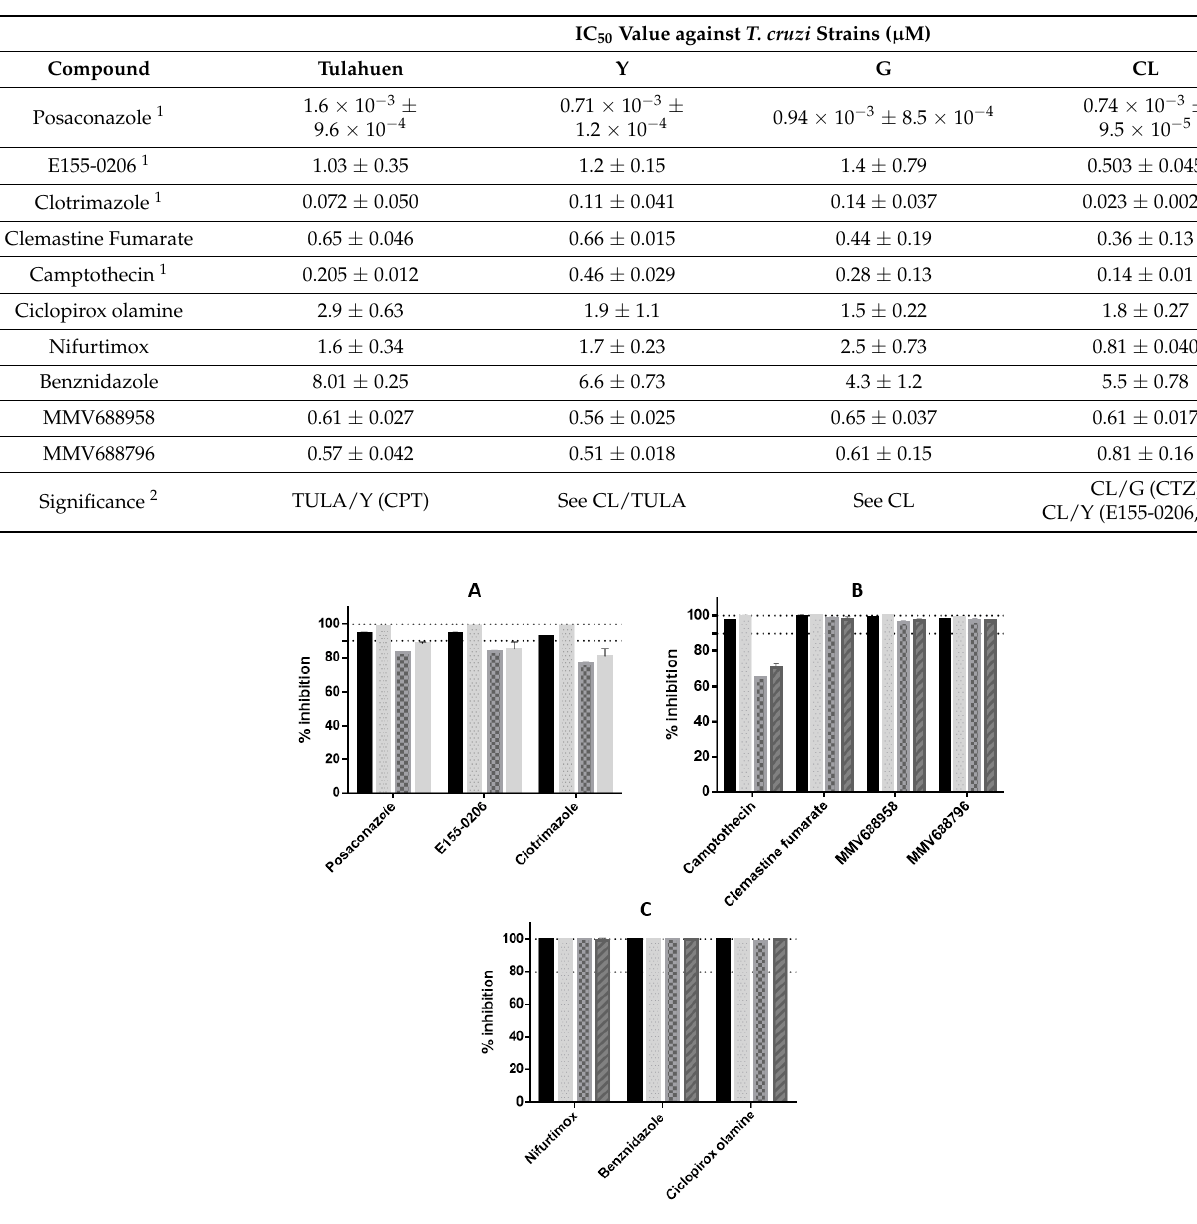
Figure 2. E max values of compounds from differing chemical classes against T. cruzi intracellular amastigotes, from Tulahuen, CL, Y and G strain parasites, following 72 h incubation. ( A ) CYP51 inhibitors ( B ) camptothecin, clemastine fumarate and two compounds from the MMV Pathogen Box collection. ( C ) compounds which cleared 100% of parasites from host cells over all strains: the nitroheterocyclic inhibitors benznidazole and nifurtimox; and the antifungal, ciclopirox olamine. Solid bars = Tulahuen strain parasite, dotted bars = CL strain, chequered bars = Y strain, striped bars = G strain. Dashes shown at 90% and 100% activity.